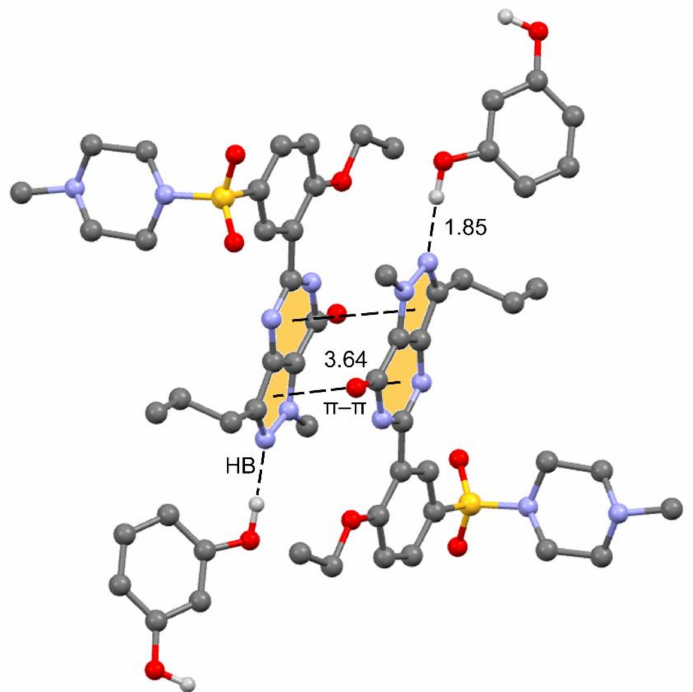
Figure 3. Partial view of the cocrystal structure showing the antiparallel π stacking and the Sildenafil ··· resorcinol H-bonds.